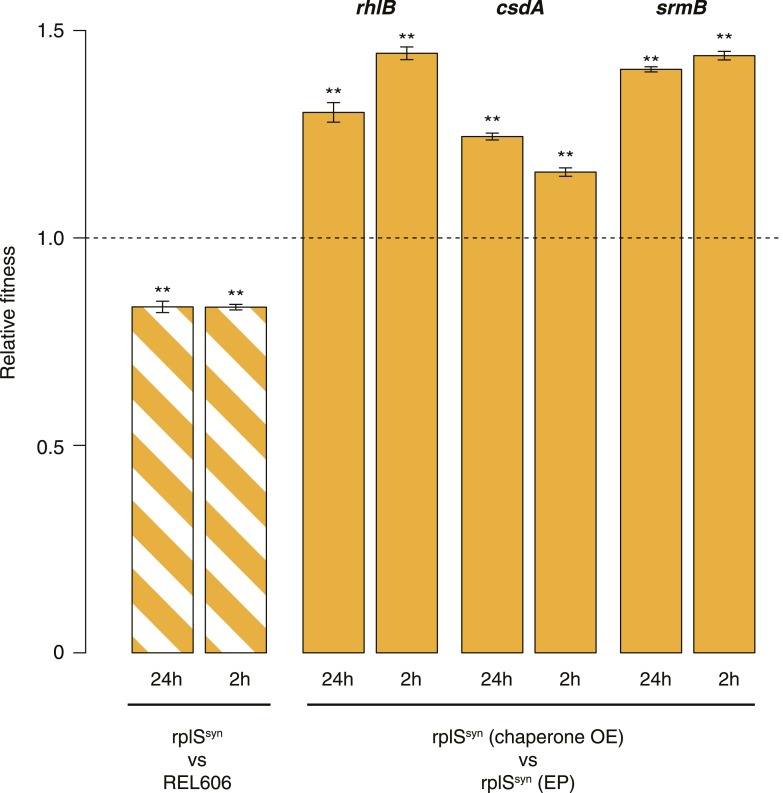
Relative fitness in competition experiments terminated in mid-exponential phase (rplSsyn).OE: overexpression; EP: empty plasmid.